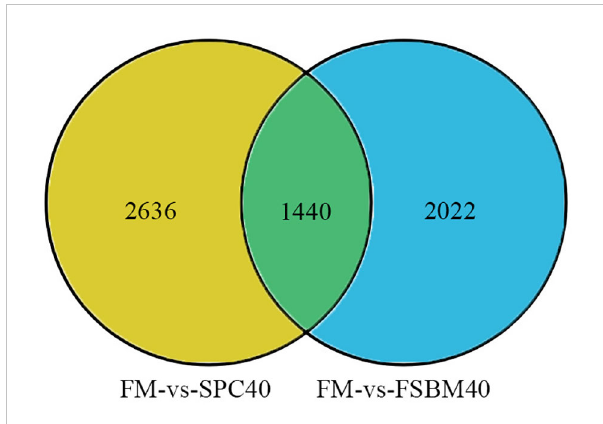
FIGURE 2 Venn map analysis of DEGs in the distal intestine of pearl gentian grouper (n =